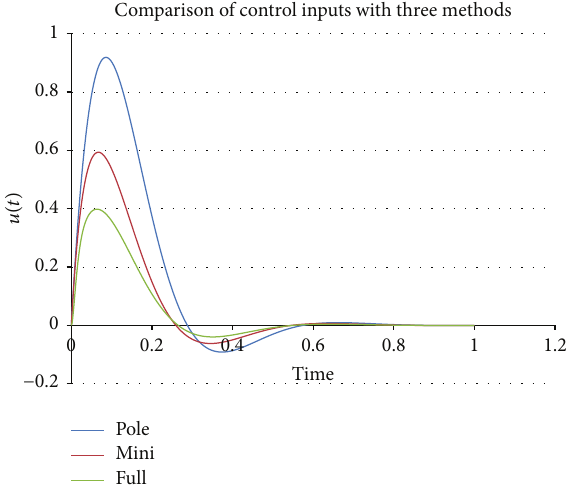
Figure 6: The control input, 𝑢(𝑡) , of the system with three methods.